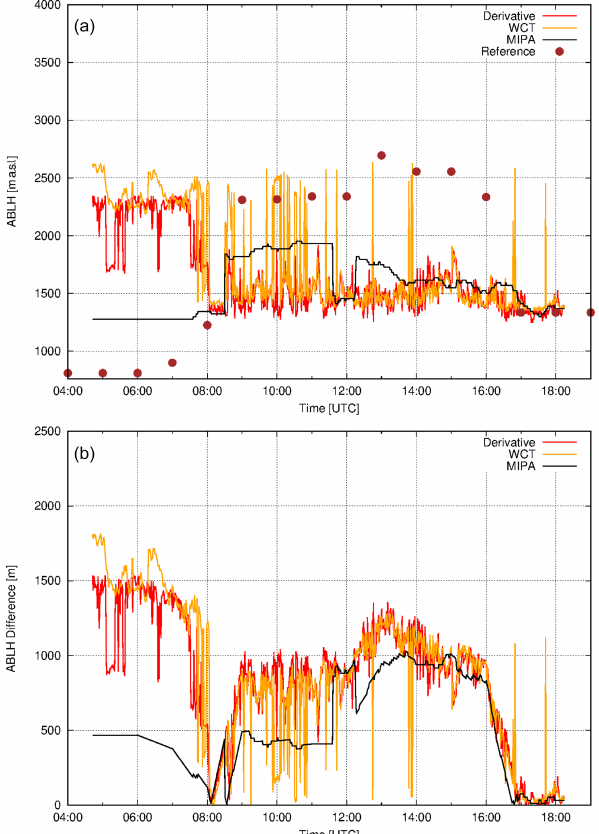
Figure 7. (a) ABLH retrieved from the Potenza lidar measurements on 21 April 2010. Black, red and yellow lines show the ABLH re- trieved from 1064nm high-resolution total attenuated backscatter time series applying MIPA algorithm, derivative and WCT algo- rithms, respectively. Brown circles represent the reference ABLHs as retrieved from atmospheric temperature and pressure profiles provided by ECMWF forecasts. (b) Absolute differences of the re- trieved ABLHs with respect to the reference. The original time reso- lution of ECMWF forecasts data is 1h. They have been interpolated at the lidar data time resolution